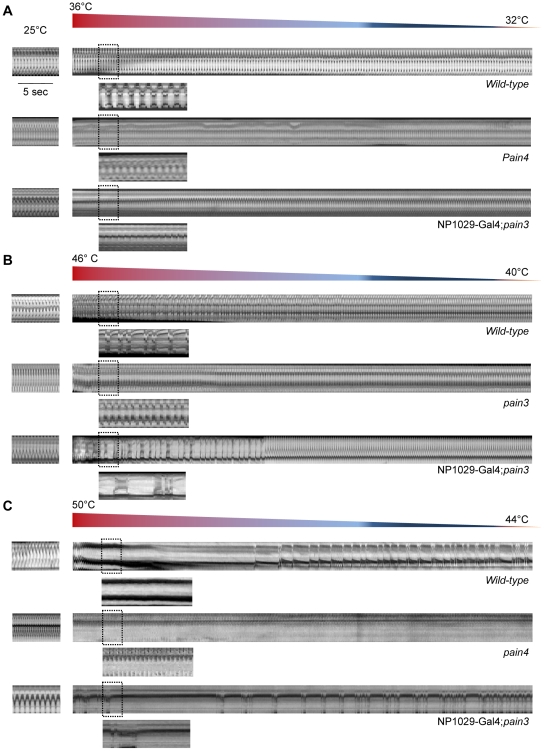
Cardiac response to Painless activation by elevated temperature.In all cases, semi-dissected preparations were first bathed in the Schneider medium at 25°C (m-modes, left). Then, the temperature of the medium in the perfusion chamber was increased at the indicated values (m-modes, right). (A) M-mode traces from movies recorded after slight temperature increase. The heart rate of wild-type cardiac tube bathed in the medium at 25°C is regular (160 bpm). When the temperature is increased to 36°C, a 14.1% increase in frequency is observed. The same type of response is observed in the pain4 mutant (7.7%) and after transgenic rescue (12.2%). (B) M-mode traces from movies recorded after moderate temperature increase. In the wild-type, the increase of temperature from 25°C to 46°C induces a strong arrhythmia with an important decrease in the cardiac rate (−23.7%). In pain3 individuals, the rise in temperature induces tachycardia (20.2%) but no arrhythmia was observed. The bradycardia and the associated arrhythmia observed in the wild-type are recovered in the pain3 rescue (−18.5%). In both the wild-type and the rescue, the regular beating is progressively recovered when the temperature drops back. (C) M-mode traces from video-movies recorded during high temperature increase. In wild-type, increasing the temperature from 25°C to 50°C leads to a cardiac pause and the heart restarts to beat firstly irregularly, then the basal rhythm is recovered. In the mutant, like for both lower temperatures, increasing the temperature to 50°C induced a strong tachycardia but no cardiac arrest is visible. Rescuing pain expression in the heart restores the cardiac pause and the prolonged arrhythmia. The basal rate is recovered after 12 min.